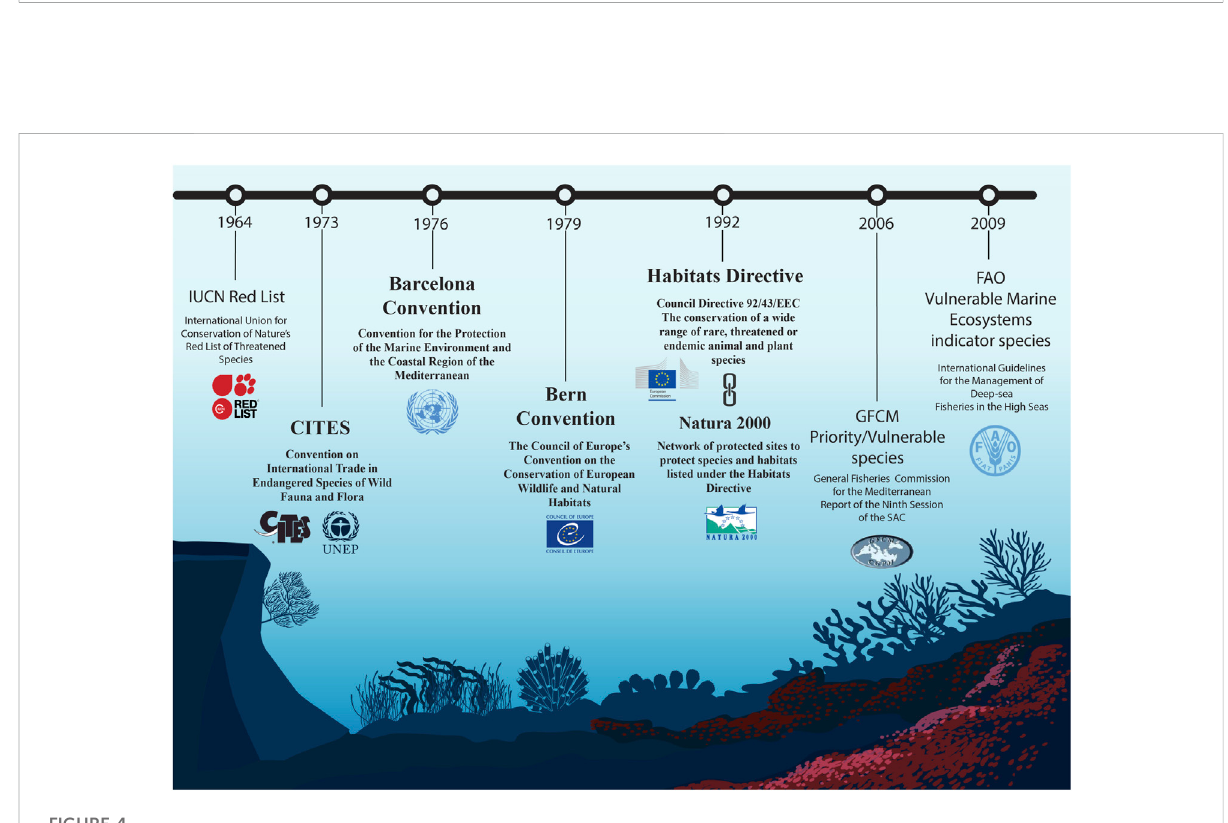
FIGURE 4 International Legislative Framework, comprising binding (bold font) and not-binding instruments, which also includes Mediterranean mesophotic habitats and taxa. The establishment years and depositary organisms are